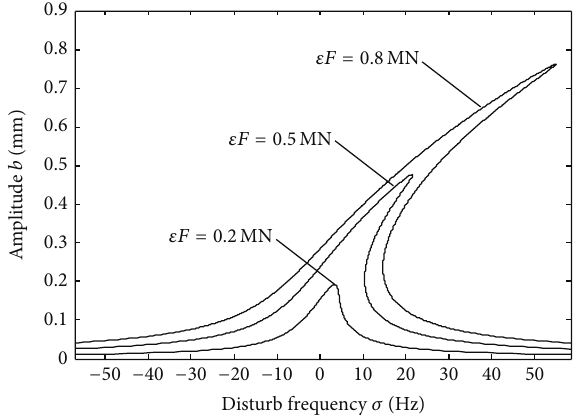
Figure 7: Curve of main resonance amplitude frequency with different disturb amplitude 𝜀𝐹